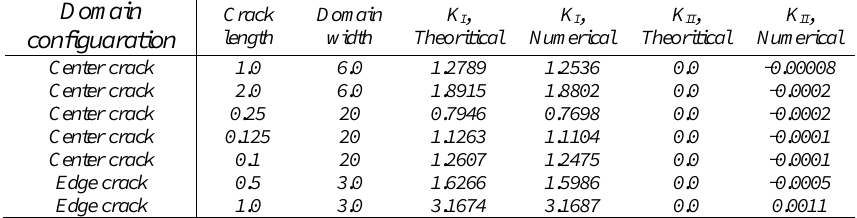
Table 1. Numerical and theoritical values of stress intensity factors in different conditions